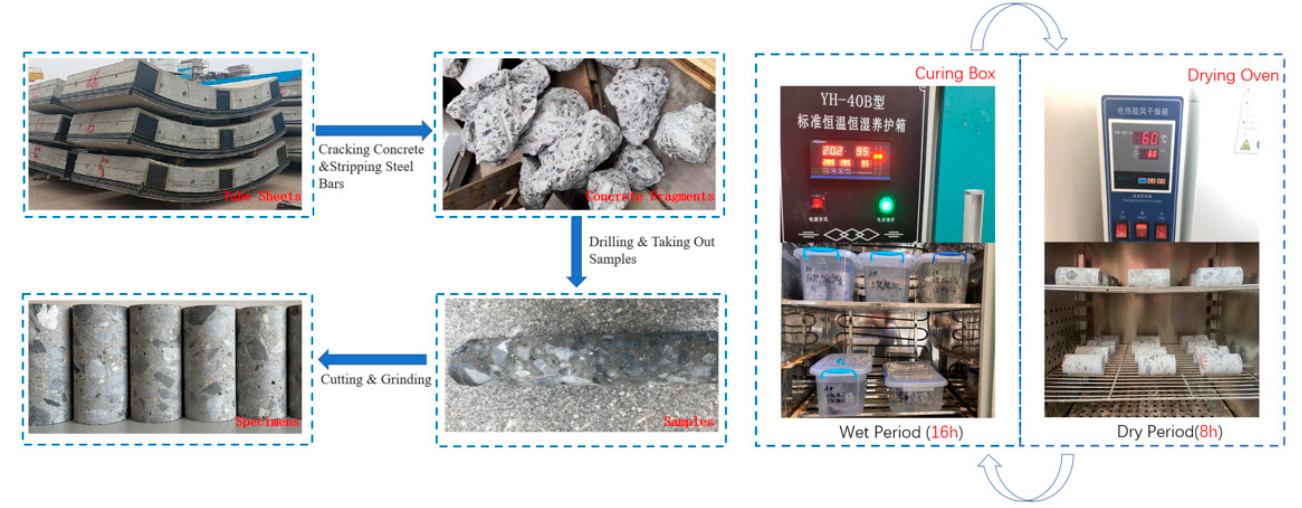
Figure 1. Sample preparation and test.